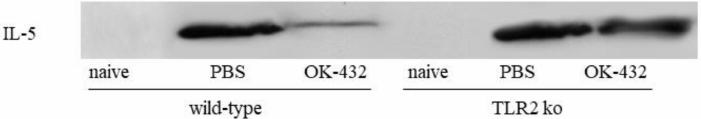
Figure 12. IL-5 expressions of nasal mucosae assessed by western blot assay, in a murine model of wild-type and TLR2 knock-out mice systemically sensitized with OVA and receiving subsequent intranasal challenge of OVA. Naive mice underwent no systemic sensitization. PBS-treated mice were i.p. injected with PBS on day 0 and day 7. OK-432-treated mice were i.p. injected with 100 mg OK-432 on day 0 and day 7. IL-5 expression was detected in PBS-treated wild type of mice and TLR 2 knock-out mice. Interestingly, it was also detected in OK-432-treated TLR2 knock-out mice, whereas it was downregulated in PBS-treated wild-type